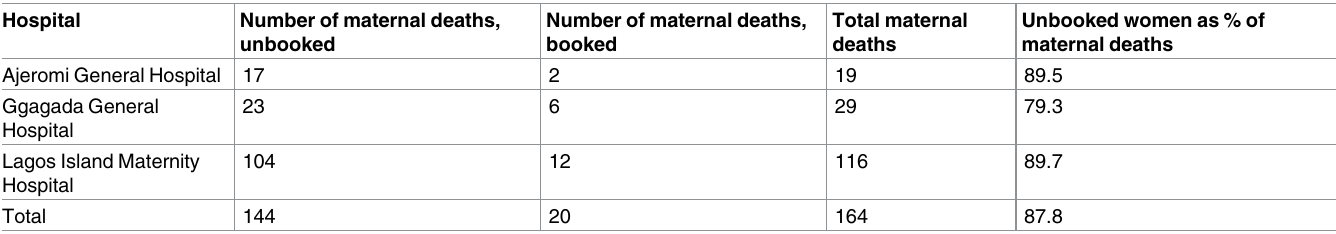
Table 2. Maternal deaths by hospital booking